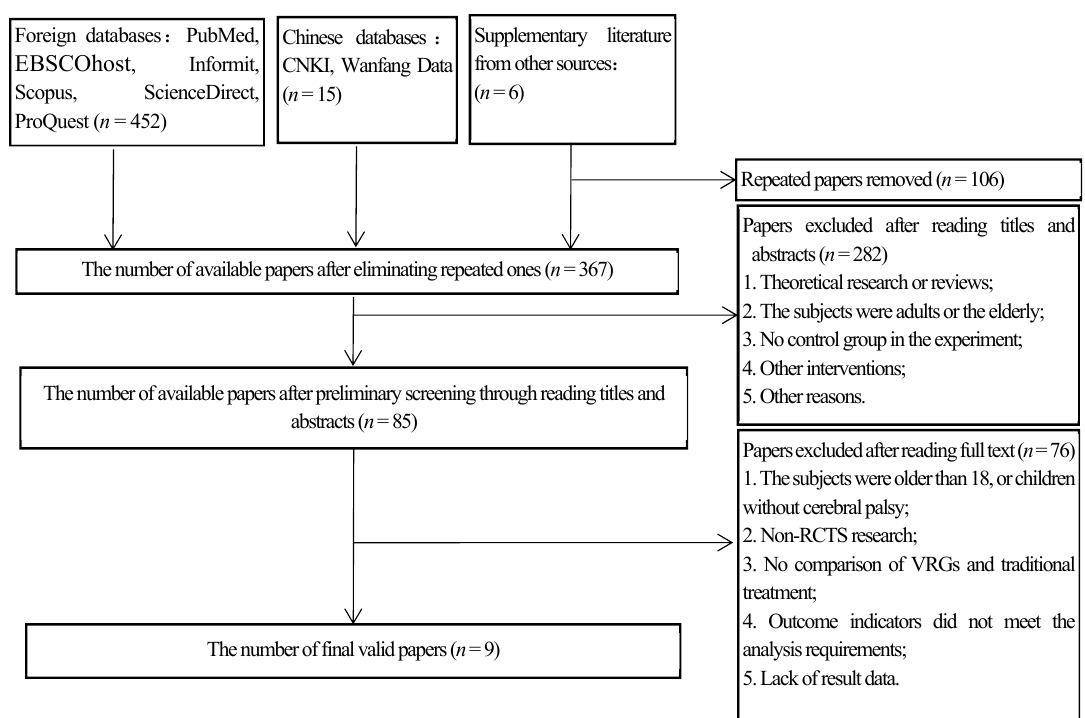
Figure 1. The flow chart of literature screening.